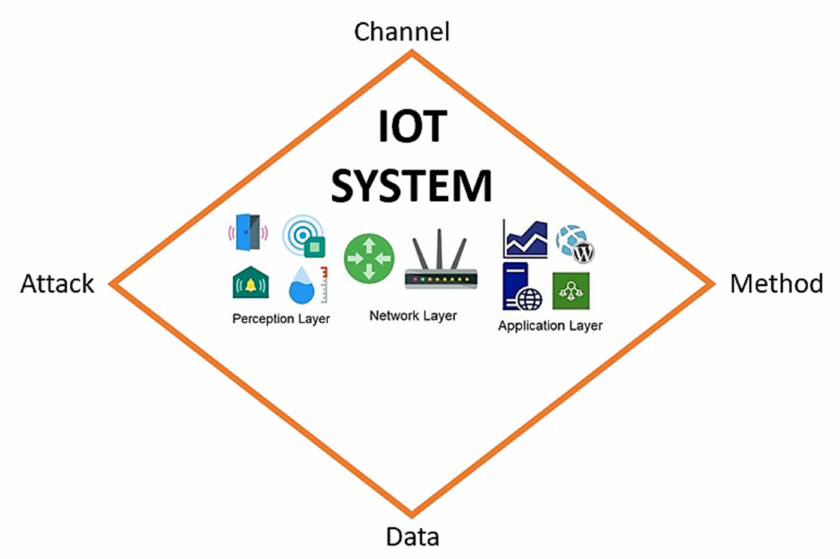
Figure 8. IoT attack surface variables.